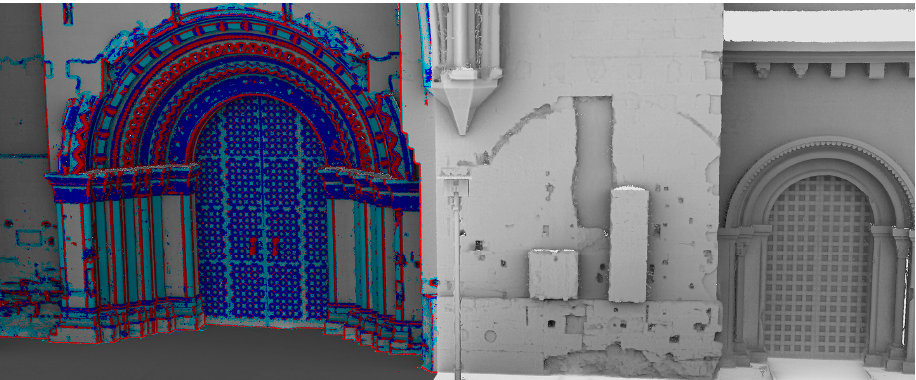
Figure 3. 3D point cloud. CANUPO classification and illumination by ambient occlusion [11]. Classification: floor is shown in gray, the walls are blank, the ornamental elements are shown in blue, and the linear elements in red.